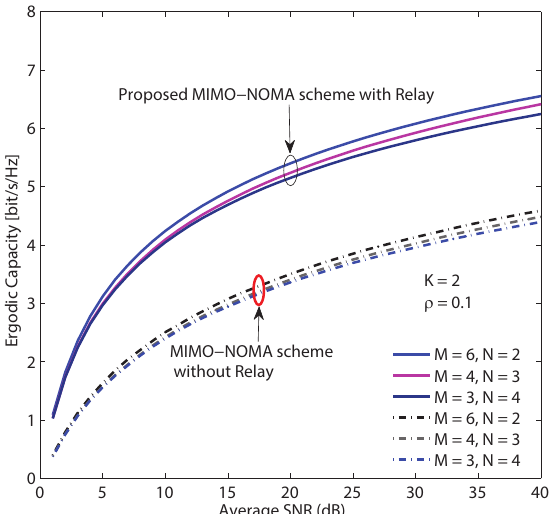
Figure 11. Sum ER of the system versus SINR in two cases of perfect and imperfect SICs with ξ 1 = ξ 2 = 0.06.